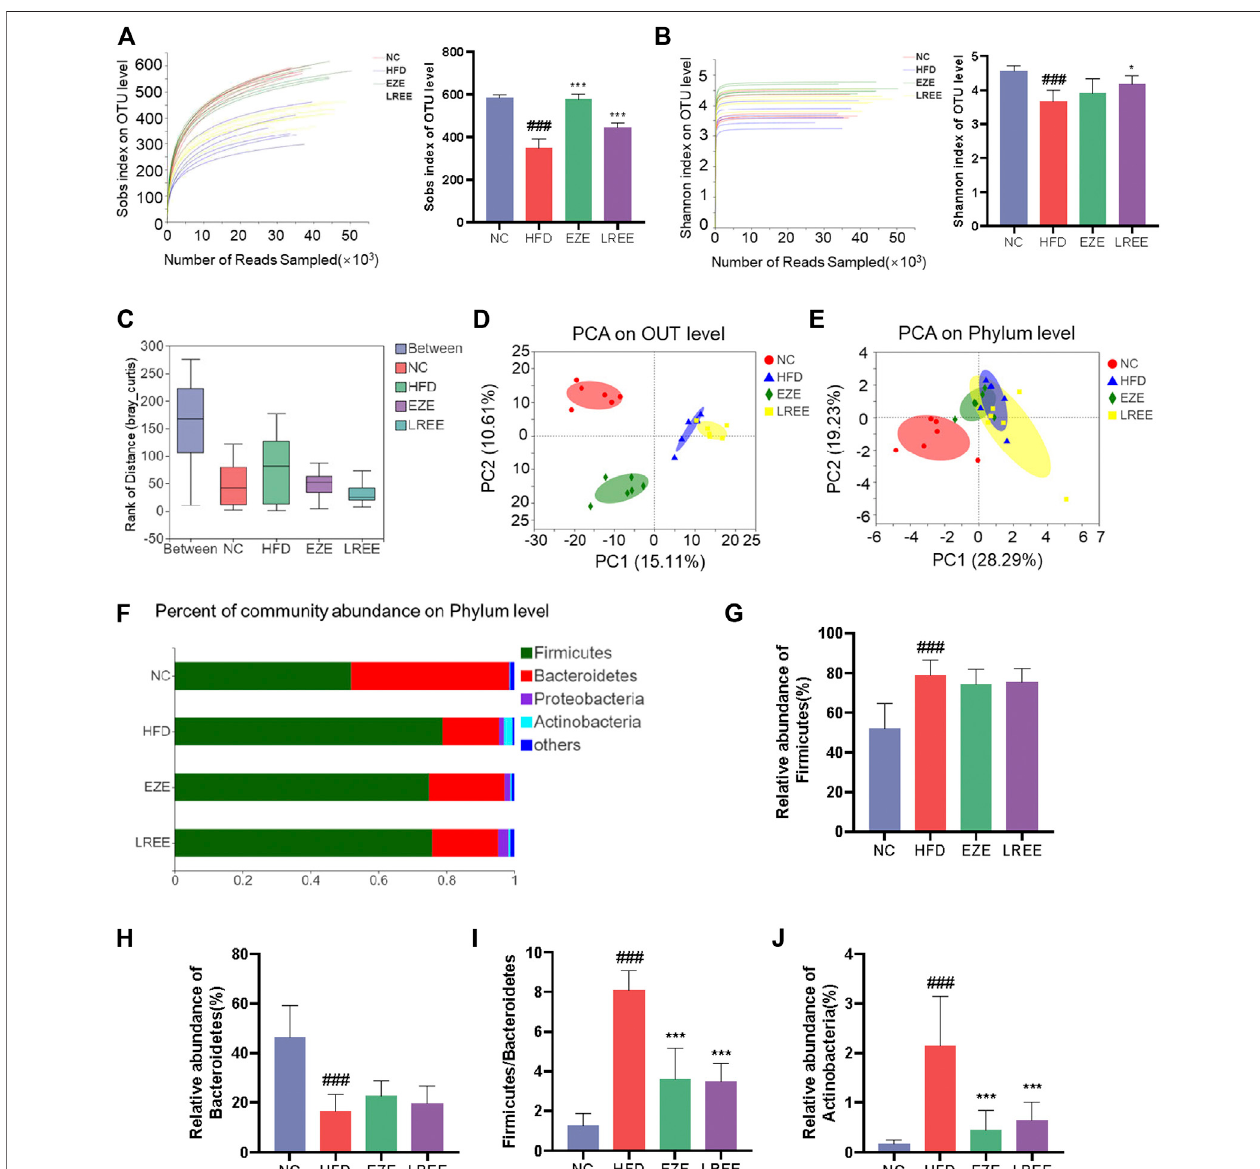
FIGURE4| Diversityanalysisforbacteriaindiversegroups.Sobsindex (A) andSimpsonindex (B) rarefactioncurveandtheOUTlevel (C) ANOSIM/Adonisanalysis offourgroups. (D) PCAanalysisoffourgroupsinOUTlevel. (E) PCAanalysisoffourgroupsinphylumlevel. (F) Theproportionofmajorbacteriainphylumlevelanddetail abundance of fi rmicutes (G) , Bacteroidetes (H) , the ration of F/B (I) , and Actinobacteria (J) . ### p < 0.001 via the NC group; * p < 0.05, ** p < 0.01, *** p < 0.001via HFD group.